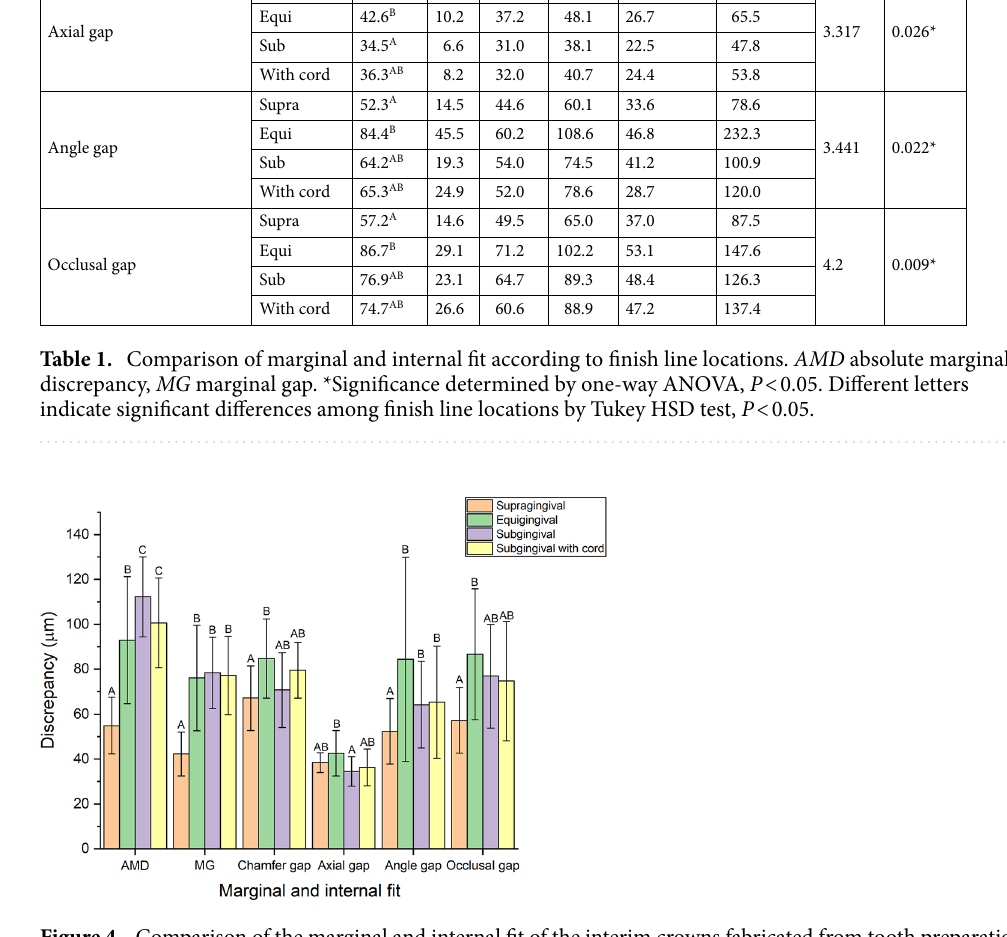
Figure 4. Comparison of the marginal and internal fit of the interim crowns fabricated from tooth preparation scanned at four finish lines. Different letters indicate significant differences among finish line locations by Tukey HSD test, P < 0.05. AMD absolute marginal discrepancy, MG marginal